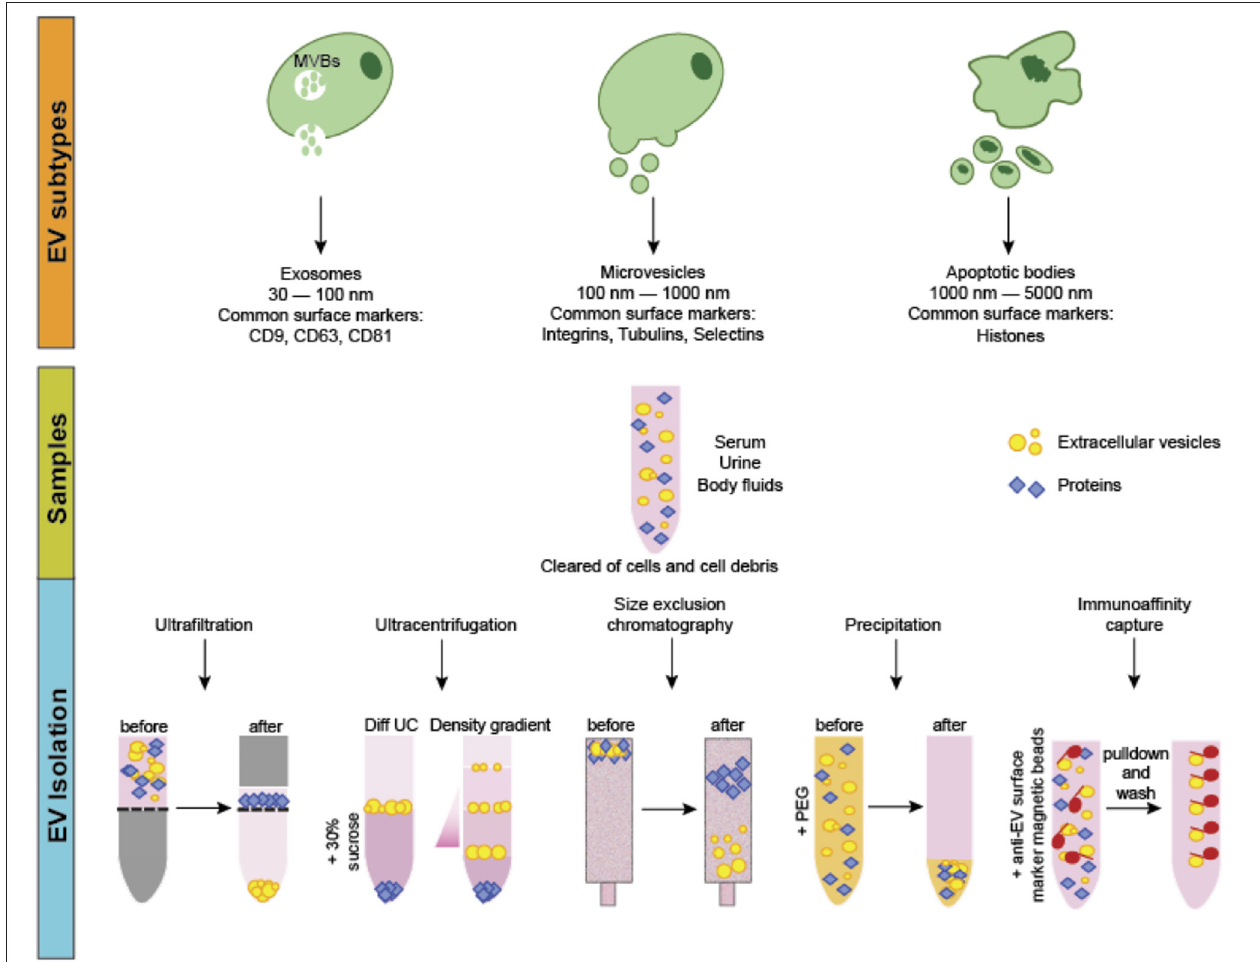
FIGURE 1 | EV classification, biogenesis and isolation. EVs can be classified into three main categories. Apoptotic bodies (ABs) are the largest in size and are released from cells undergoing apoptotic cell death. Microvesicles (MVs) are considered as medium-sized EVs generated via membrane budding and shedding. Exosomes are the smallest EVs formed as multivesicular bodies. Production and secretion of microvesicles and exosomes generally involves specialized molecular machineries such as the endosomal sorting complexes required for transport and lipid rafts. EVs can be isolated via several methods including ultrafiltration, size-exclusion chromatography, differential and density gradient ultracentrifugation, precipitation and immunoaffinity capture. Often, samples are first centrifuged to remove cells and cellular debris. For ultrafiltration and size-exclusion chromatography, EVs are isolated through nanomembrane filters based on their sizes. In ultracentrifugation and density gradient centrifugation, different EV types are sequentially isolated based on physical properties such as density and sedimentation rate. For precipitation-based methods, the addition of water-insoluble polymers force and concentrate the EVs from the other components in the samples. Immunoaffinity capture method involves isolating particular EV types based on the use of magnetic beads coupled with antibodies that bind specifically to a known EV-specific surface marker for